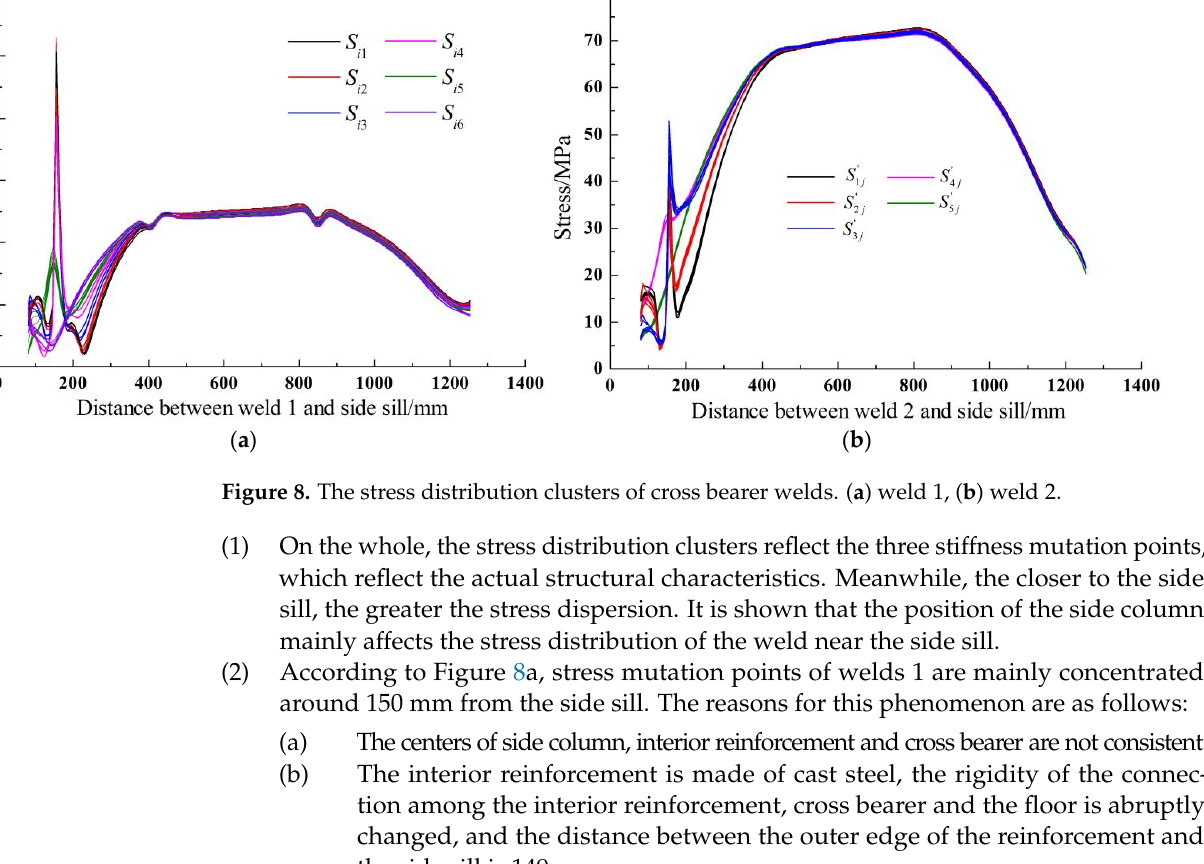
Table 3. The stress value at intersection point (MPa).